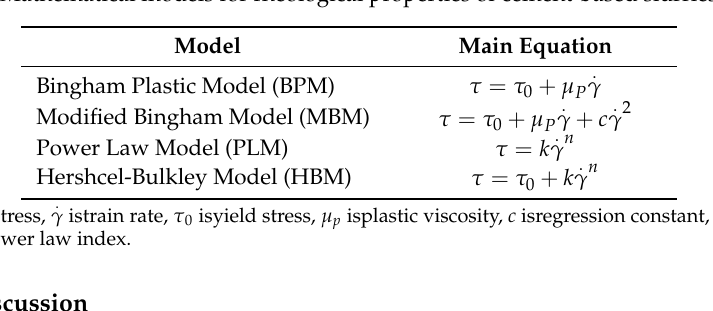
Table 2. Mathematical models for rheological properties of cement-based slurries [1,18].